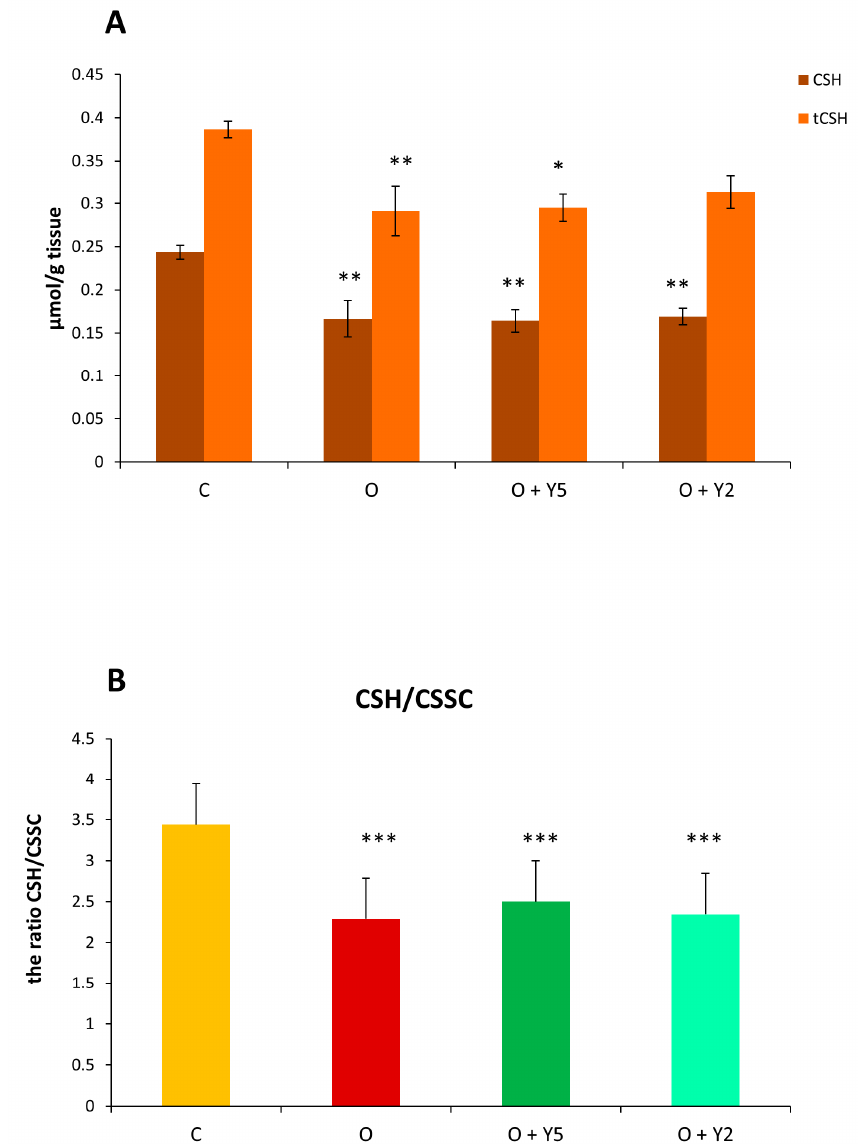
Figure 7. The level of reduced (CSH) and total (tCSH) cysteine ( A ) and the CSH/CSSC ratio ( B ) in the livers of rats. C—control rats fed a standard diet; O—rats fed with HFD; O + Y5—rats fed with HFD and treated intraperitoneally (i.p.) with yohimbine at a dose of 5 mg/kg/day for 30 days; O + Y2—rats fed with HFD and treated intraperitoneally (i.p.) with yohimbine at a dose of 2 mg/kg/day. Data are presented as the mean ± SEM, n = 6 per group. Statistical analysis was performed using a one-way ANOVA; symbols indicate significance of differences according to the Tukey post hoc test, * p < 0.05, ** p < 0.01, *** p < 0.001 vs. group C.